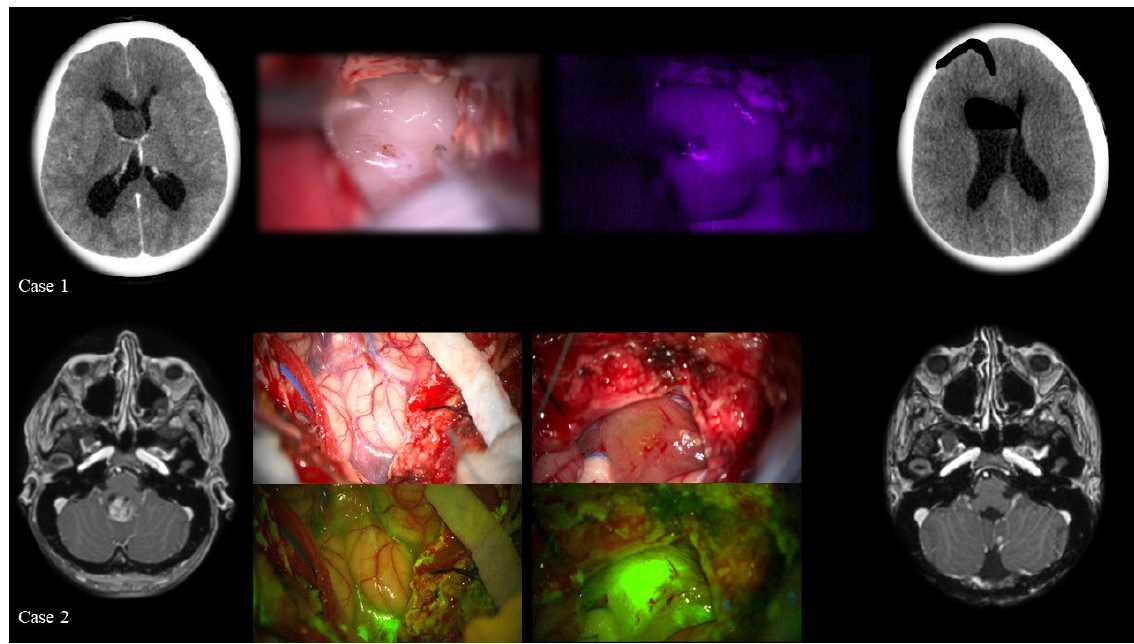
Figure 2. Supratentorial (case 1) and infratentorial (case 2) ependymomas. Case 1: a 50-year-old female patient with a lesion in the frontal horn of the right lateral ventricle: a right fronto-parietal transcortical approach was used to remove the tumor whose histology, based on the WHO classification, was A grade I ependymoma). From left to right: pre-operative CT scan; intraoperative image of the tumor under white light microscope illumination; blue light illumination using 5-ALA: in this case the tumor was not fluorescent; and finally, the post-operative CT scan. Case 2: a 29-year-old female patient with an intraventricular lesion in the IV ventricle, with moderate contrast enhancement in T1-weighted MRI scan. The histological diagnosis revealed a grade III ependymoma (WHO